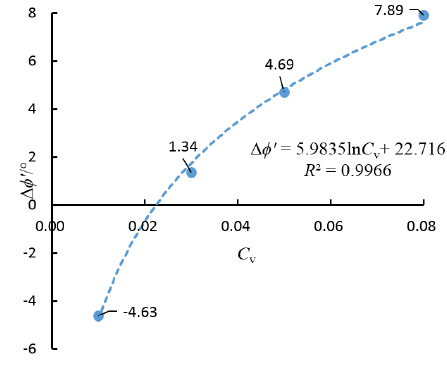
Figure 10. The relationship curve for Δϕ′ and C v .